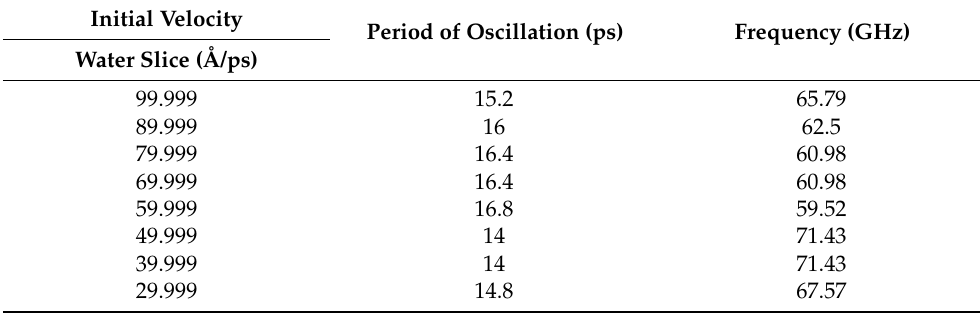
Table 1. Initial velocity of water molecules in shockwave initialization water slice vs. measured frequency of the virus structure